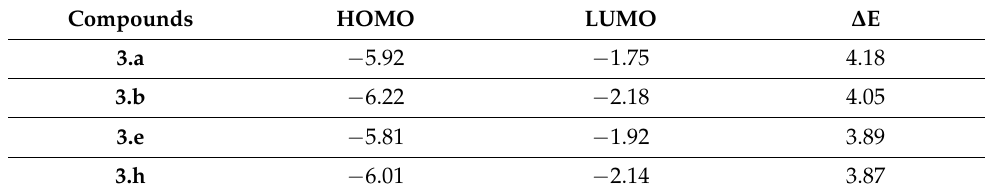
Table 3. FMO Energies e.V. and their values for the prepared compounds 3.a , 3.b , 3.e and 3.h